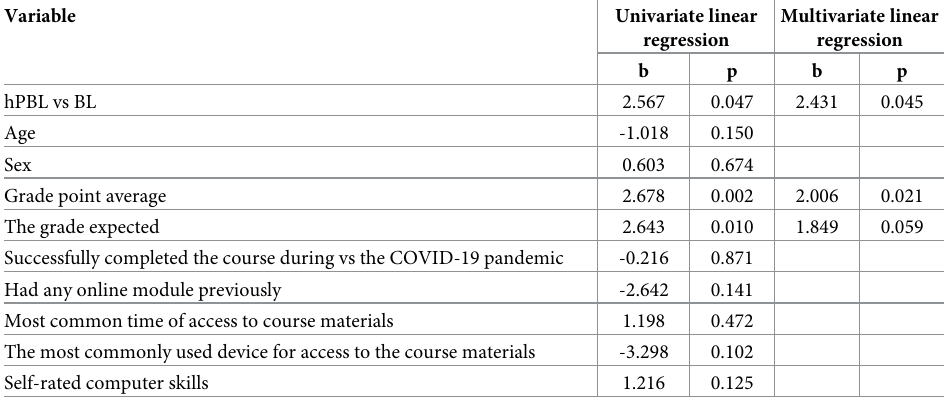
Table 5. Regression models with total medical statistics score as an outcome